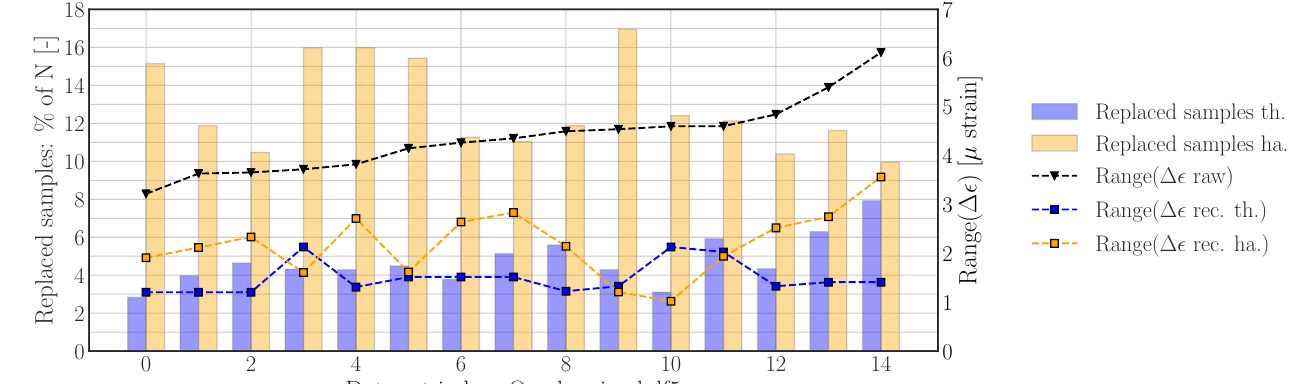
Figure 15. Reconstruction results using threshold filter-based method and Hampel filter-based method with default settings for data contained in Overlapping.hdf5 . Left axis : number of replaced samples per file. Right axis : range of sample-wise difference signal before (raw) and after reconstruction